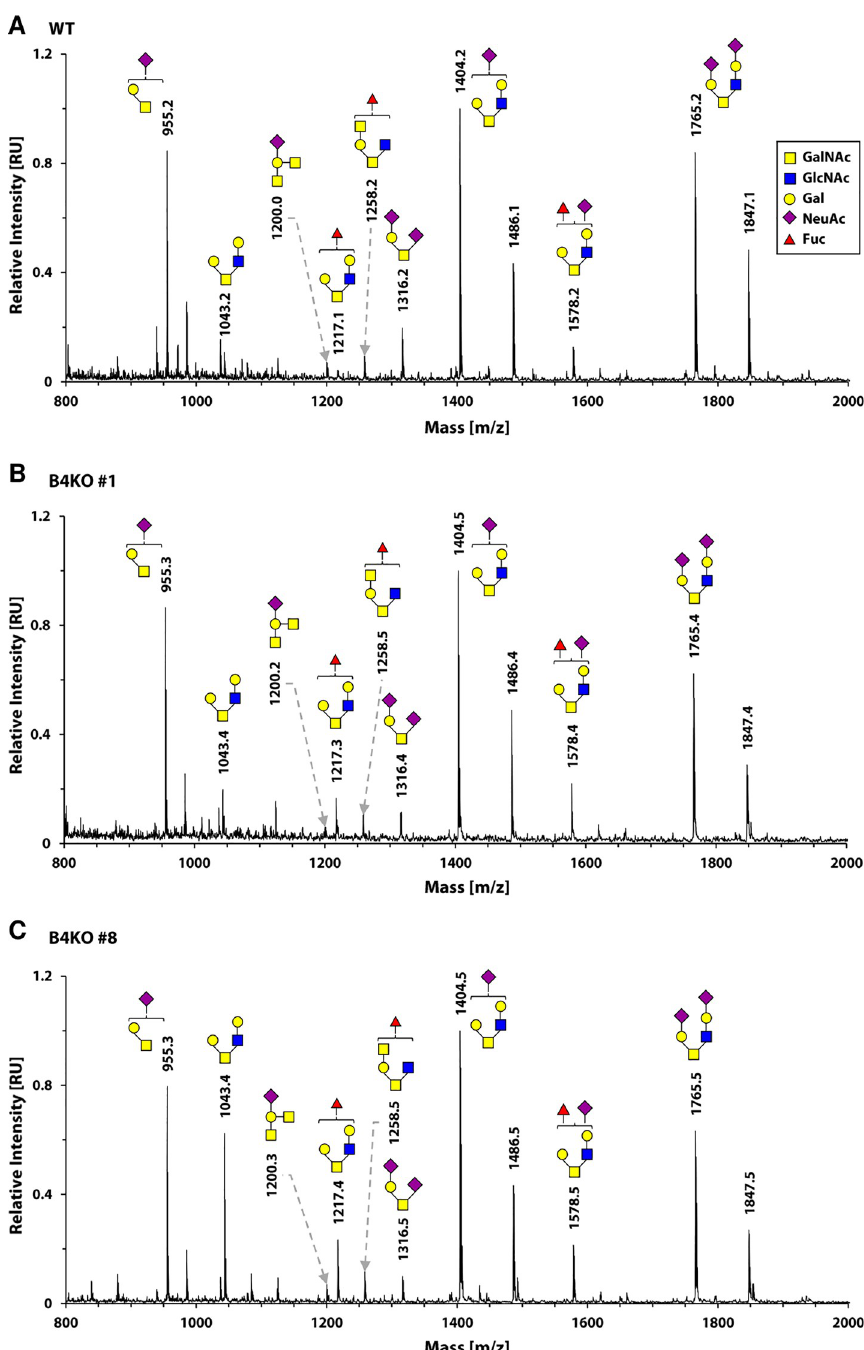
Fig 13. Analysis of O -glycans structures in the wild-type and SLC35B4 knock-out HepG2 cells. MALDI-TOF-MS characterization of permethylated Bn- O -glycans secreted to culture medium by wild-type (WT) (A) and SLC35B4-deficient (B4KO) (B,C) HepG2 cells. Spectra were scaled for maximum value. Identified peaks were labeled with mass information and cartoon representations of putative O -glycan chemical structures (based on biosynthetic knowledge). Identification of phosphorylated or sulfated glycans was not attempted. All variations of core 1- and core 2-type O -glycans detected in the wild-type cells were also detected in SLC35B4 knock-out clones showing that O - glycosylation profile was not affected. Representative data from two independent experiments are